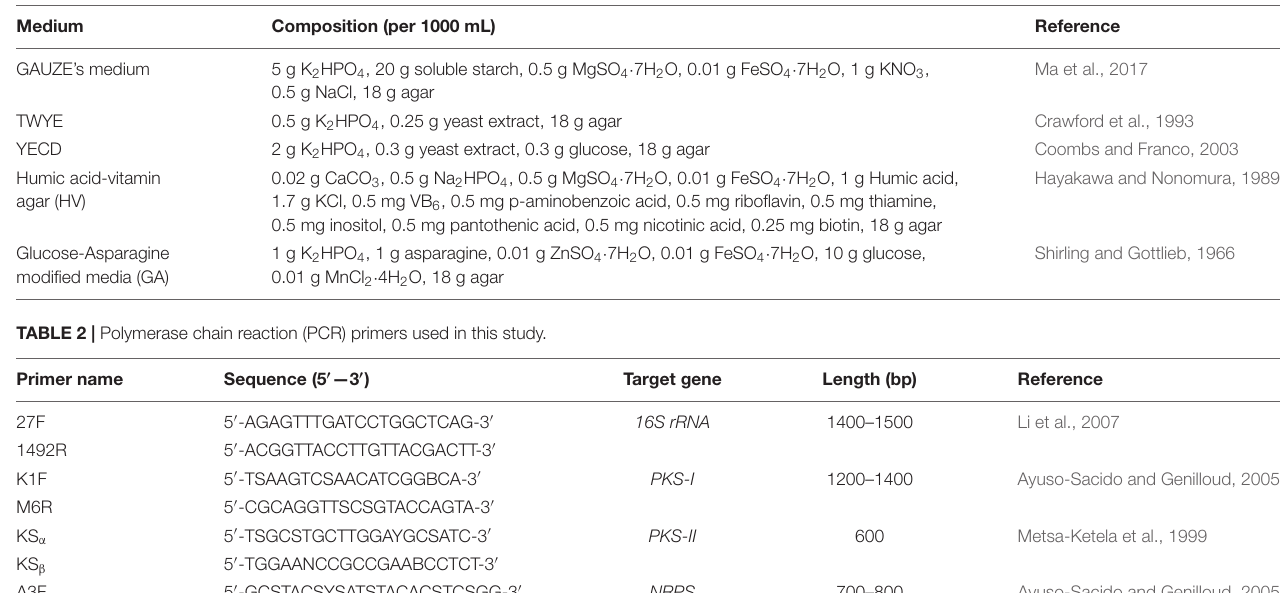
TABLE 1 | Culture medium composition for endophytic actinobacteria isolation.